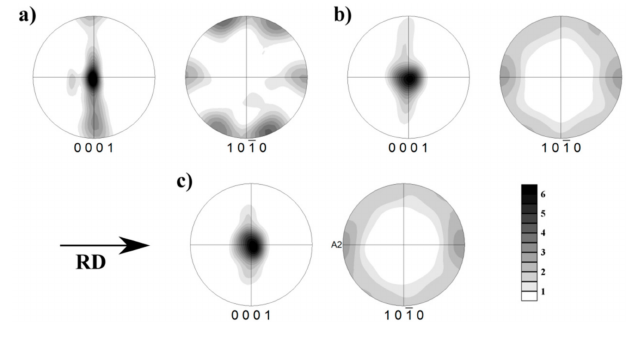
Figure 8. Texture of ARB_0 ( a ), ARB_1 ( b ) and ARB_2 samples ( c